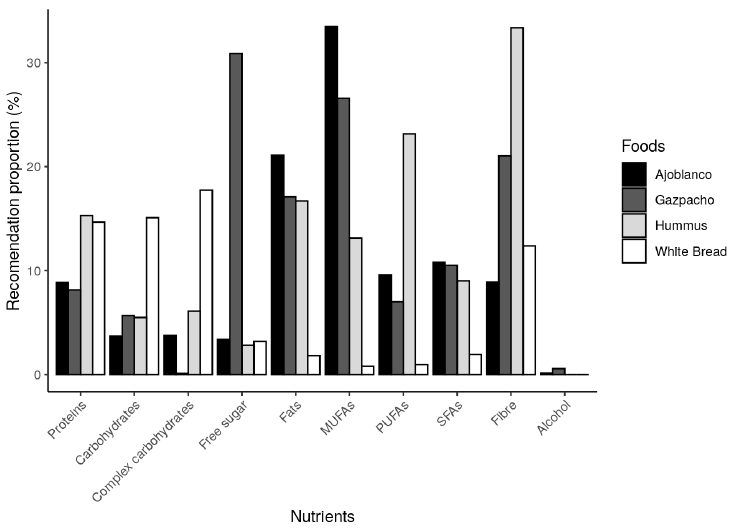
Figure 5. Percentage of macronutrients, fibre and alcohol provided by the ingested amount of each tested food, represented as a percentage of the general intake recommendations Hummus provided the highest amount of proteins, fibre, polyunsaturated fatty acids (PUFAs), P, Zn and Fe, while ajoblanco provided the largest amount of fats (except for PUFAs). The highest carbohydrate contribution was observed in white bread, which also contributed the second highest amount of protein. Focusing again on gazpacho, low quantities of proteins, total and complex carbohydrates and PUFAs were observed, whilst providing the largest amount of free sugar, compared with the other three tested foods. Nevertheless, as Figure 6 shows, in accordance with Figure 4, gazpacho contained the highest DRIs proportion in almost all represented micro-nutrients, being also the second highest assessed food in the other minerals.